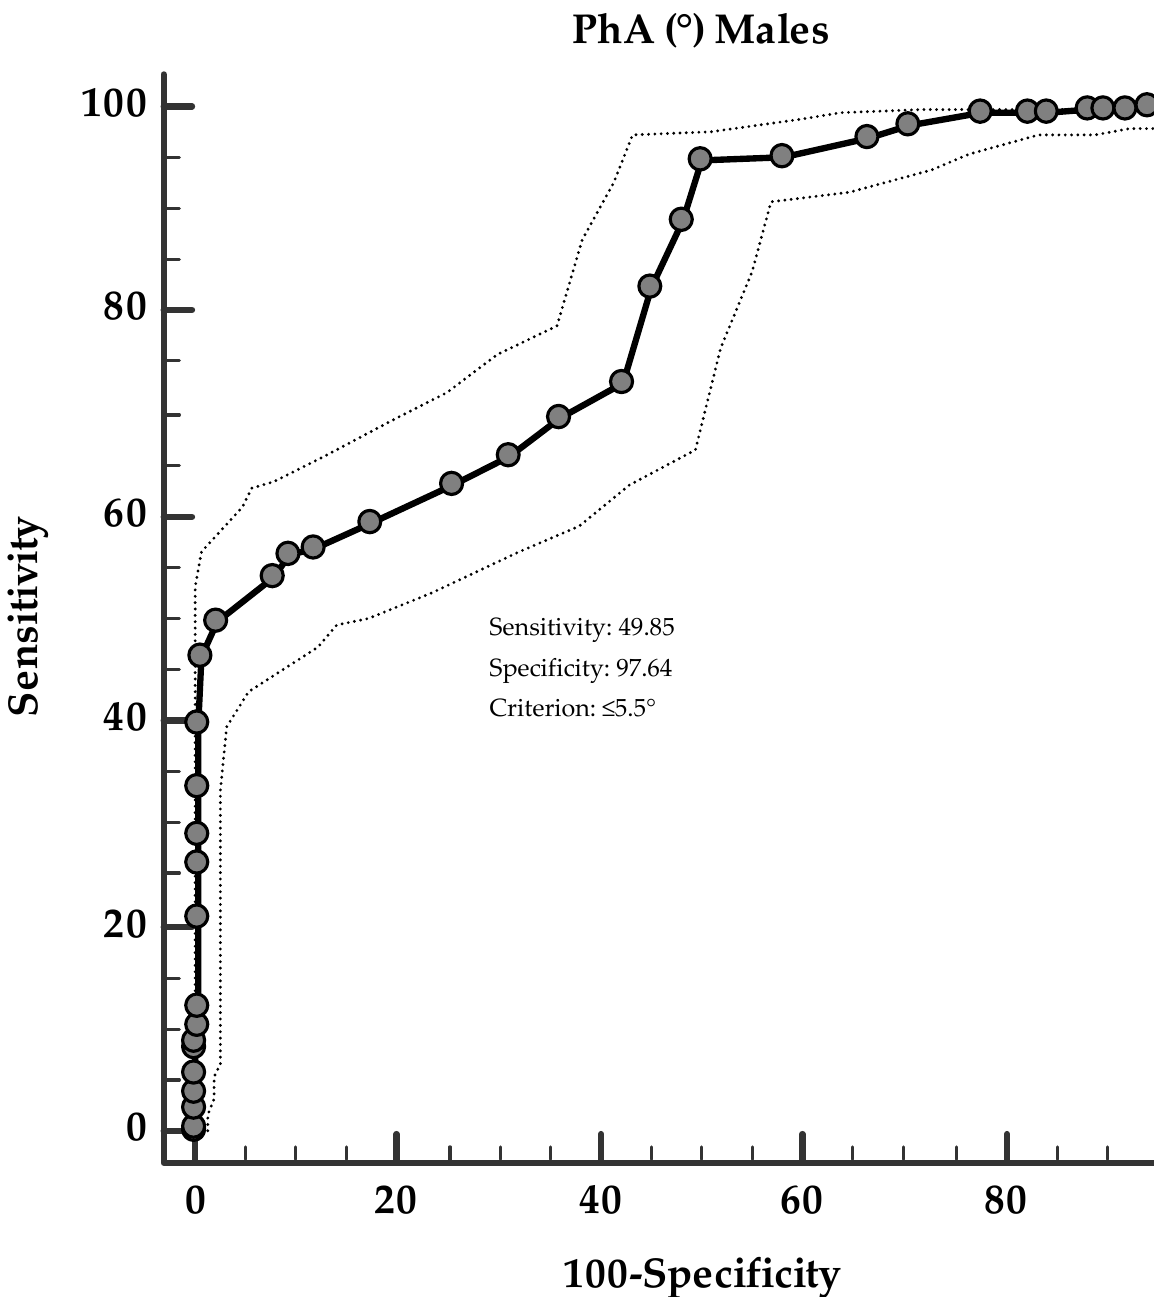
Figure 3. ROC for predictive values of PhA (°) in detecting the highest hs-CRP levels in males. * A significant difference ( p < 0.05).